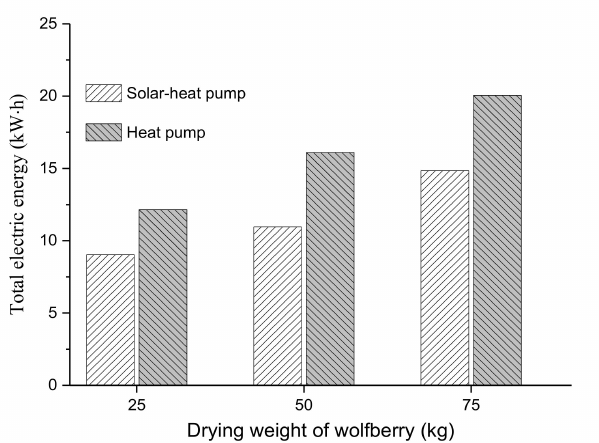
Figure 14. Hourly variation of electric energy consumption with a di ff erent drying weight of wolfberry for two drying modes.